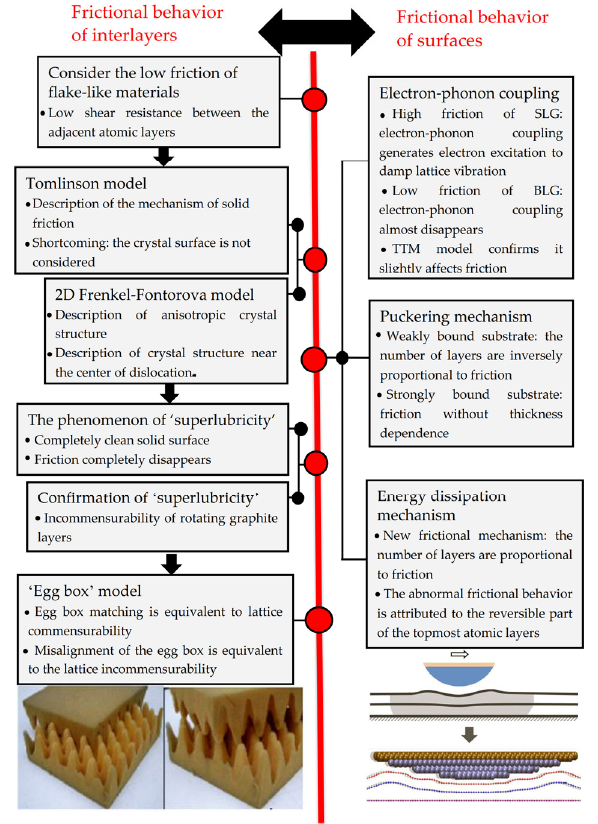
Fig. 1 Summary of frictional mechanisms of 2D materials.